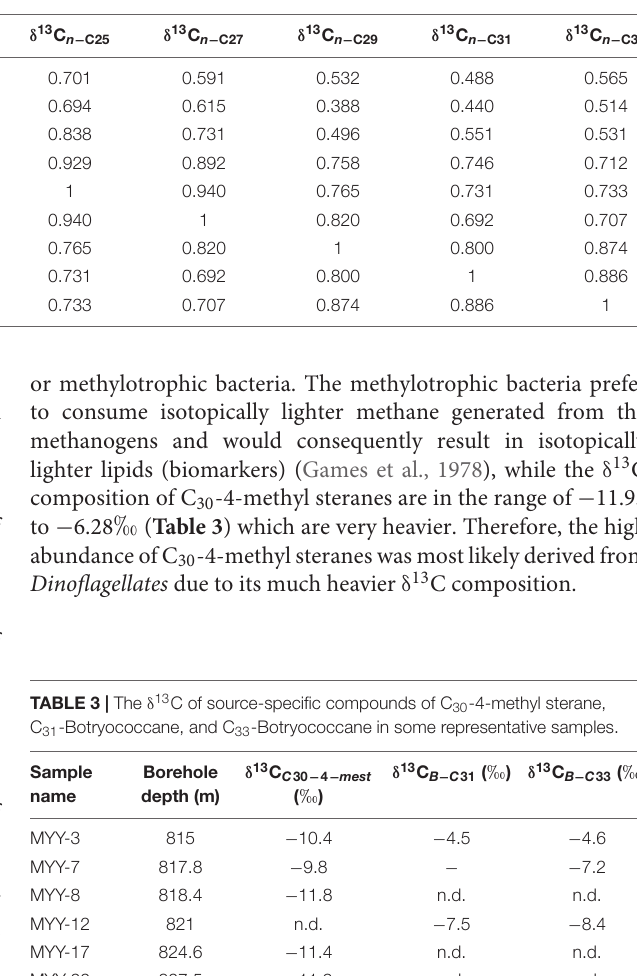
TABLE 2 | Pearson coefficient of correlation between the δ 13 C composition of the bulk organic matter and individual n -alkane compounds. δ 13 C org